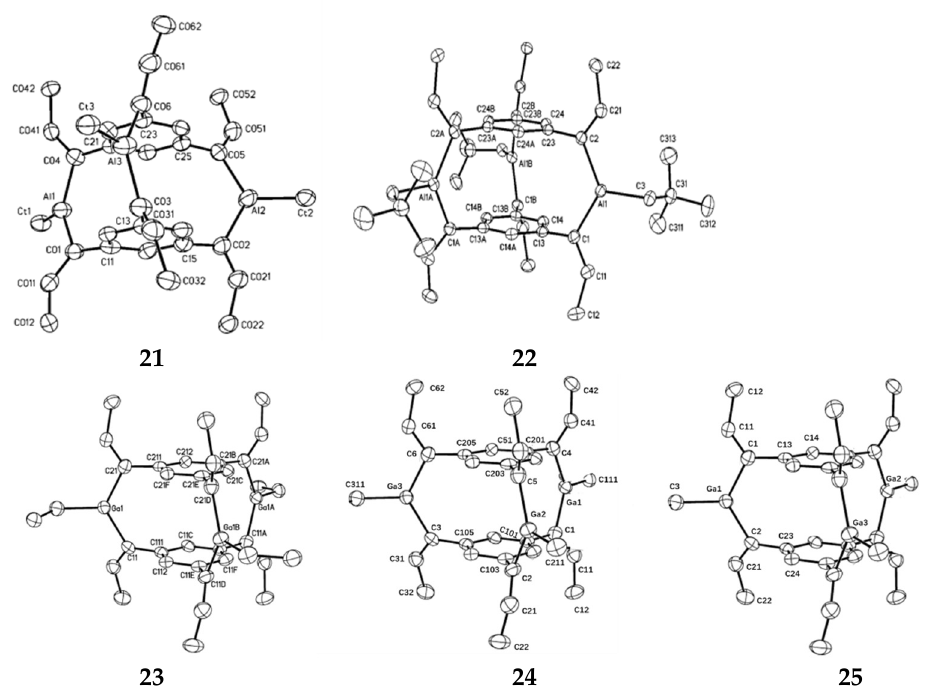
Figure 14. ORTEP drawings of complexes 21 , 22 , 23 , 24 , and 25 (the probability of thermal ellipsoid is 50%).